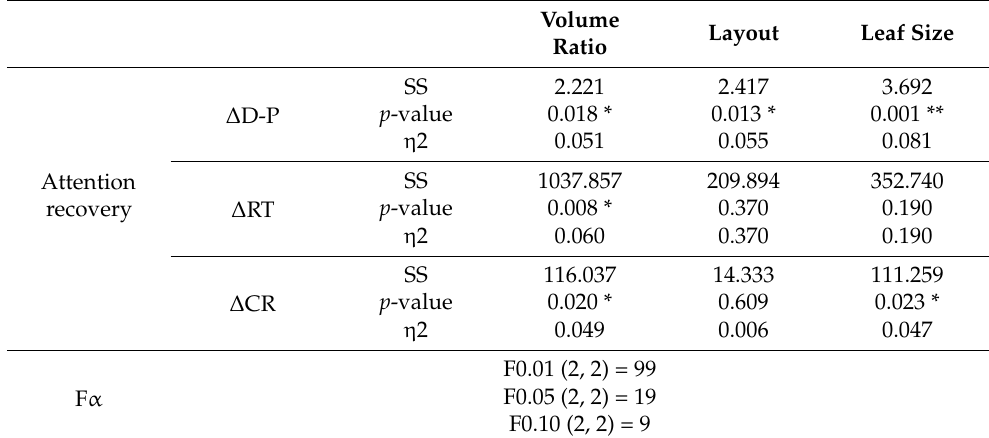
Table 5. Results of analysis of